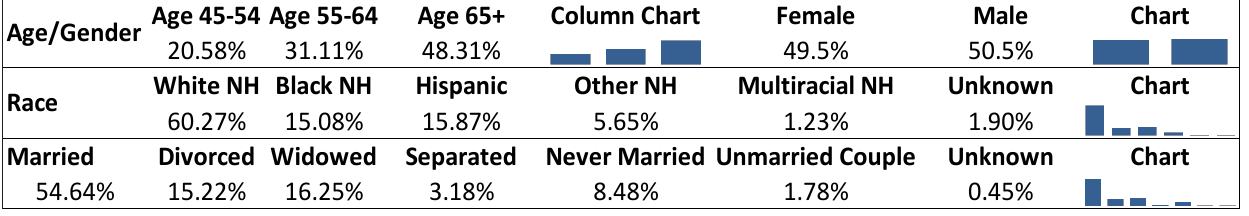
Figure 3. Marginal distributions for demographic variables.